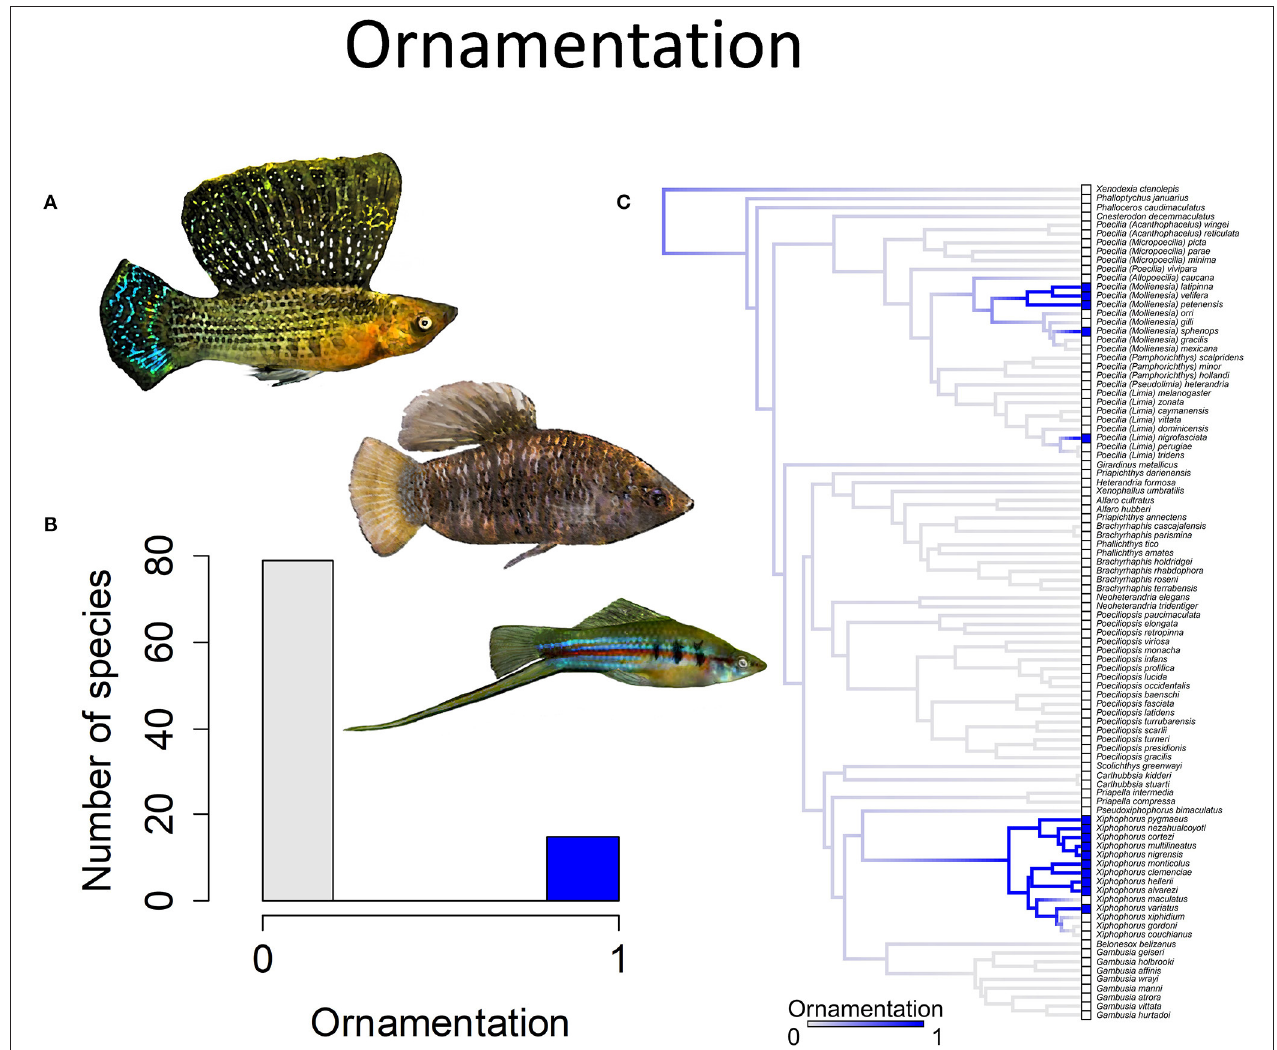
FIGURE 4 | Ornamentation in the family Poeciliidae is when males exhibit ornamental display traits such as (A) a sail-like dorsal fin, as depicted in Poecilia velifera (top) and Limia nigrofasciata (middle), or a sword-like extension of the caudal fin, as depicted in Xiphophorus hellerii (bottom). (B) Frequency histogram of presence or absence of male ornamentation ( n = 94). (C) Ancestral state reconstruction of ornamentation as a binary character was performed using stochastic character mapping in the R package phytools. Branch colors represent posterior densities of edge states based on 1000 stochastic character maps of each reconstruction. The phylogeny tips depict a binary categorization of ornamentation (i.e., absence vs. presence). Figure redrawn after Furness et al. (2019). The most likely ancestral state of the family is the absence of ornamentation (Furness et al.,